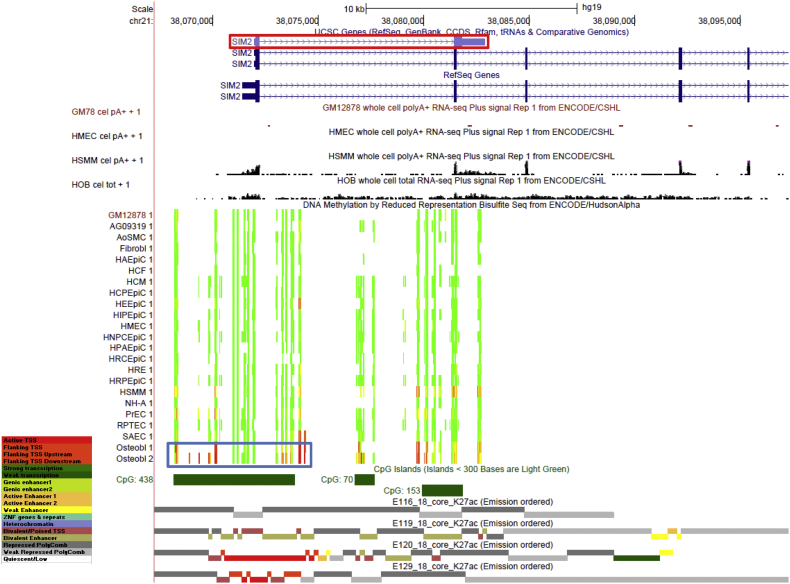
Osteoblastic hypermethylation at SIM2 TSS surrounding region. The following profiles are shown using the UCSC Genome Browser (http://genome.ucsc.edu, version hg19) for the SIM2 gene region: UCSC genes, RefSeq genes, RNA-seq data from ENCODE/Cold Spring Harbor, DNA methylation levels assessed by RRBS from ENCODE/HudsonAlpha, CpG islands, Chromatin state (18-state) annotation from NIH Roadmap Epigenome project. LCL (only GM12878 is shown, but the other LCL samples give similar results), HMEC, HSMM, and osteoblast (HOB) are the only studied cell types having both data in RNA-seq and histone modification tracks available from ENCODE. Methylation status is represented with an 11-color gradient for which red, yellow, and green represent that 100%, 50%, and 0% of molecules sequenced are methylated, respectively. Osteoblast-specific DMRs are indicated in the blue box. At this scale, individual differentially methylated CpG sites cannot be resolved from neighboring sites. The specific non-coding SIM2 isoform (Ensembl transcript ID: ENST00000460783.1) is marked in the red box. The 18 chromatin states are represented with the indicated colors, with E116 representing states for LCL (GM12878), E119 for HMEC, E120 for HSMM, and E129 for osteoblast. The detailed ChIP-seq data for various histone modification marks (H3K4me1, H3K4me3, H3K9me3, H3K27ac, H3K27me3, H3K36me3, H3K79me2, and H4K20me1) are presented in the Supplementary Fig. 3.